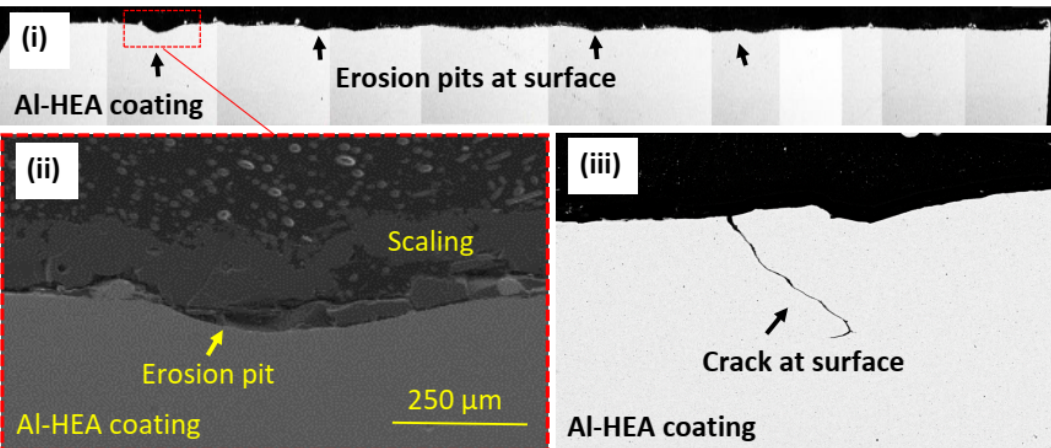
Figure 18. ( i ) Surface profile (BSE image) of exposed Al-HEA-304L sample with erosion pits at the surface, ( ii ) one erosion pit at high magnification (SEM image), and ( iii ) crack observed eroded in Al-HEA coating (BSE image) at the surface.